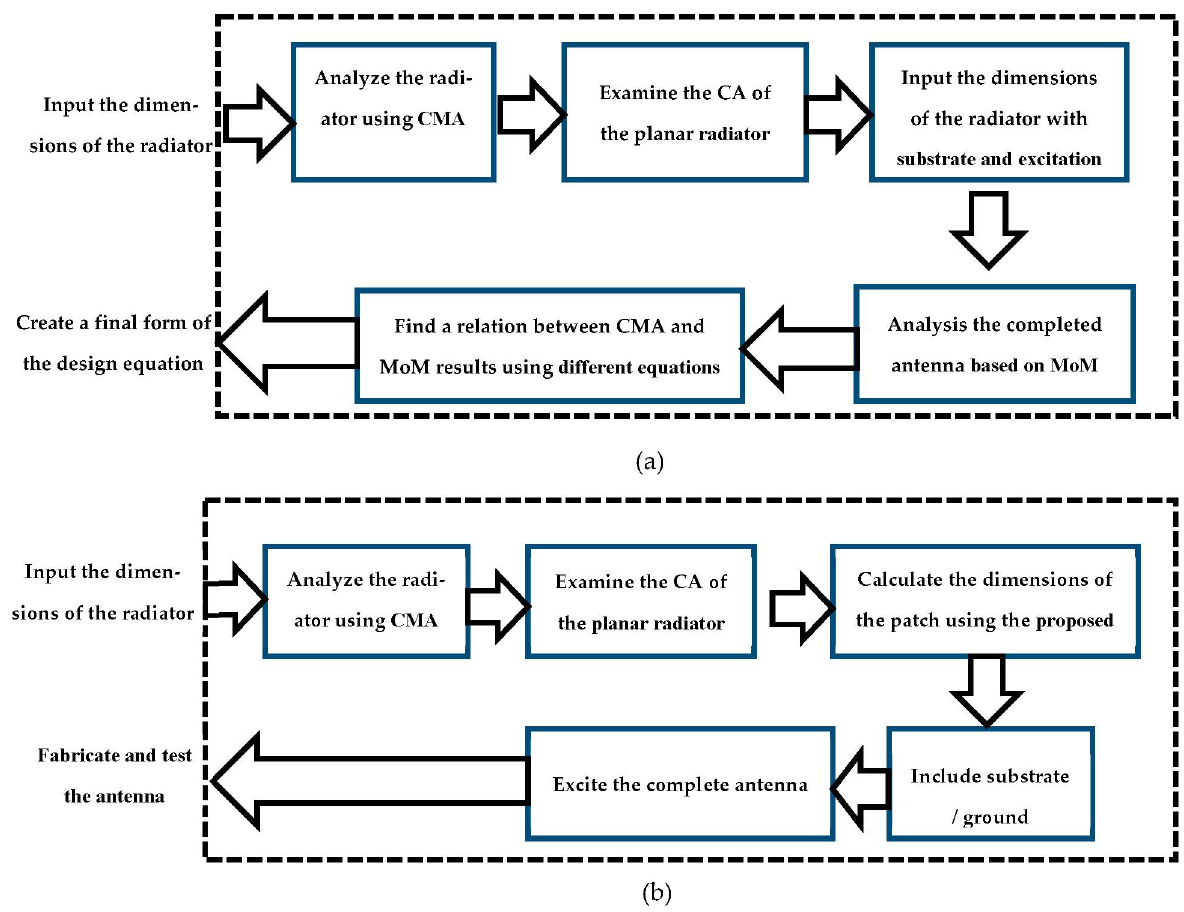
Figure 2. ( a ) Generation of the formula, and ( b ) design procedure using the proposed formula.